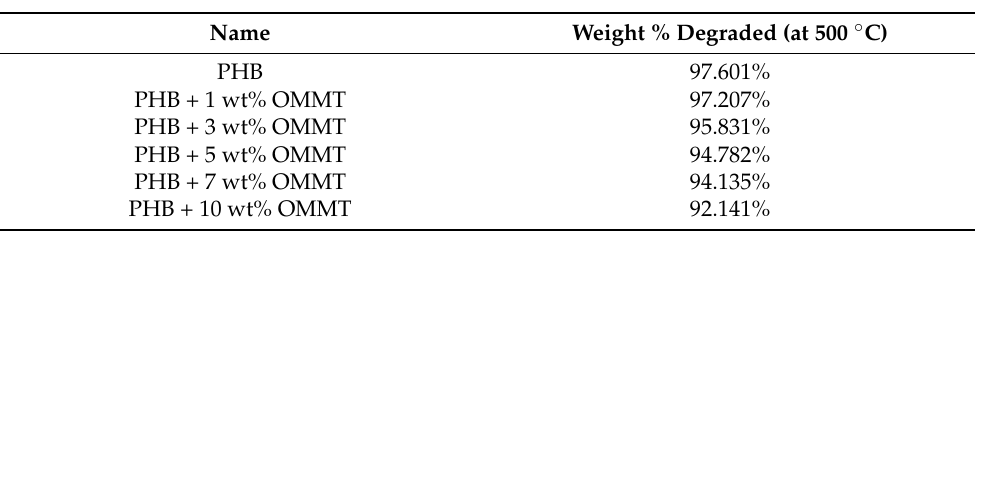
Figure 2. Degradation, melting, and upper working temperatures of different blends. Table 1. Weight percentage degradation of blends from